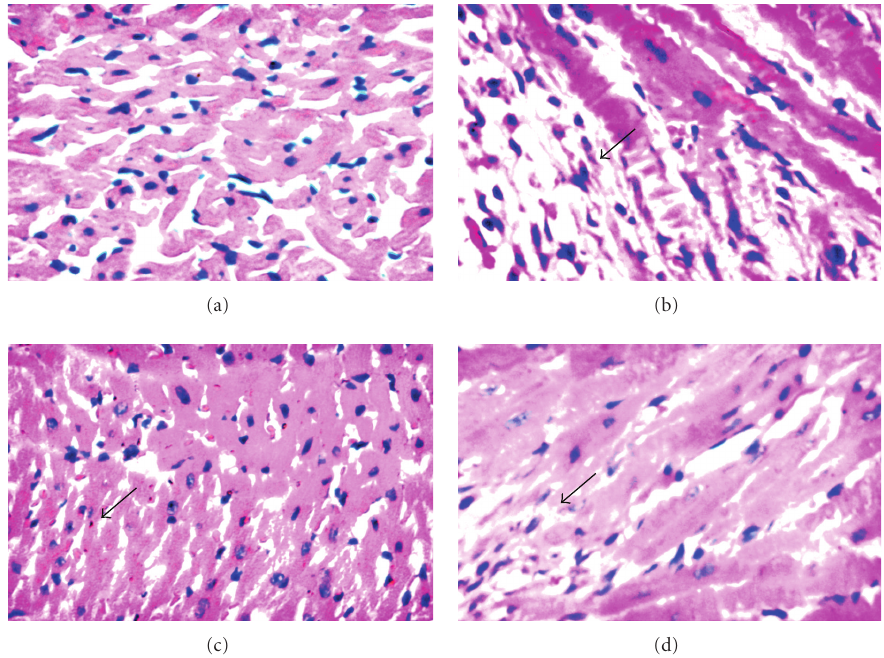
Figure 2: H&E staining of rat myocardial cells; arrows show the infarcted tissue ( cells is normal. (b) Control ischemic group. Myocardial necrosis is obvious. (c) Preischemic treatment group. (d) Delayed application group. Myocardial necrosis reduced in (c) and (d).